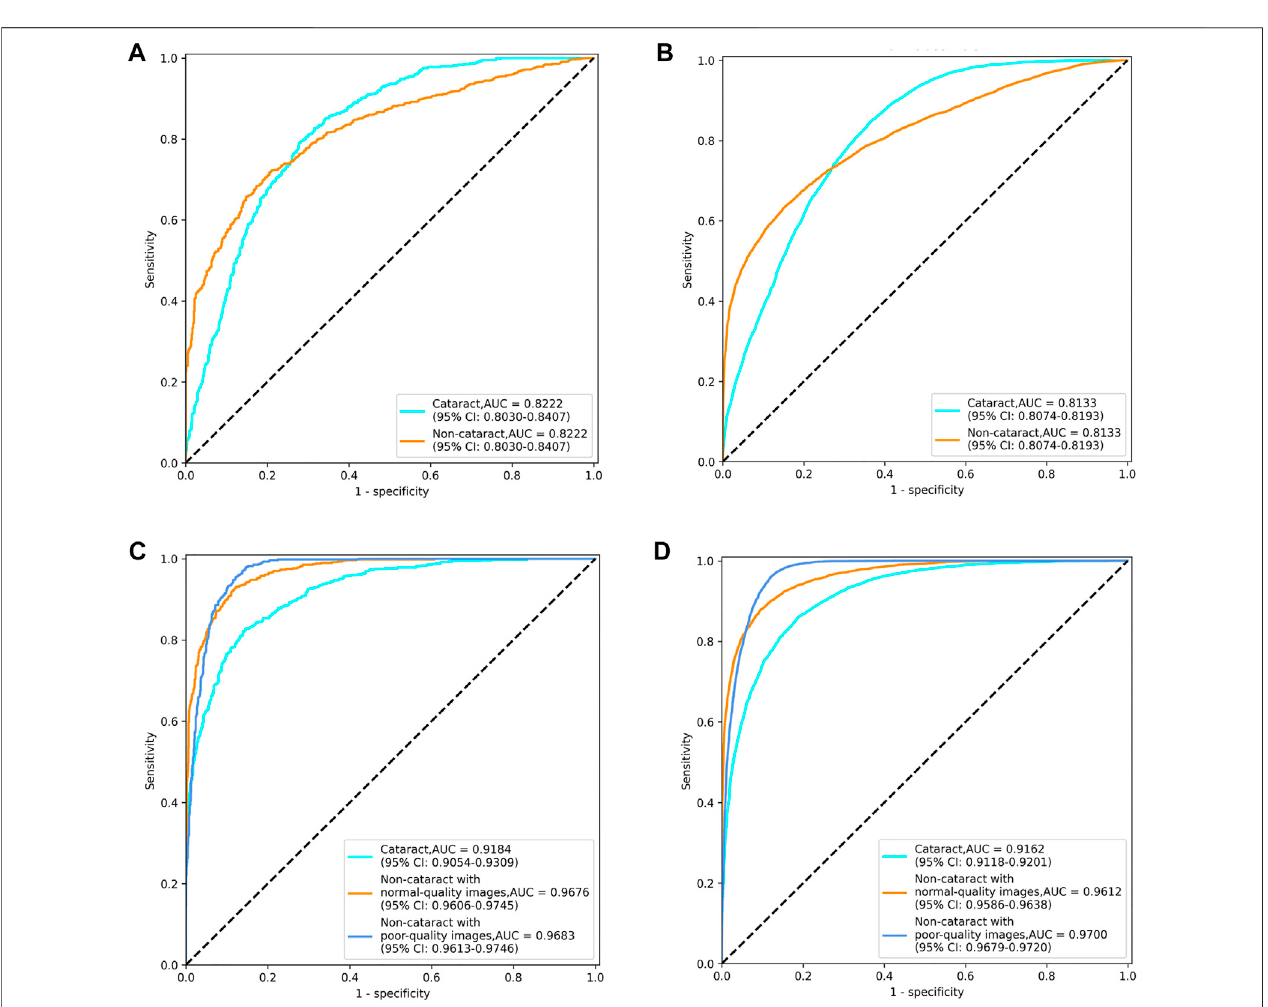
FIGURE 4 | Receiver operating characteristic curves of the two cataract arti fi cial intelligence diagnosis models. (A) binary-class model in the internal validation dataset. (B) binary-class model in the external test dataset. (C) antiinterference model in the internal validation dataset. (D) antiinterference model in the external test